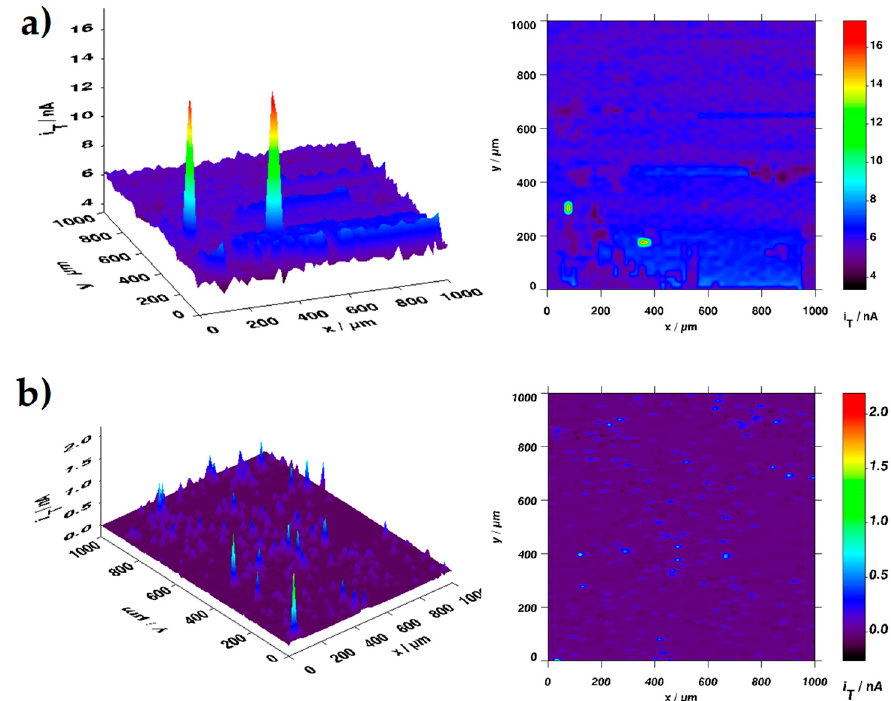
Figure 4. SECM images of: a ) PMMA and b ) PMMA + SiO 2 0.01% coatings. The current of the peaks is is related with defects on the surface of the related with defects on the surface of the coatings.